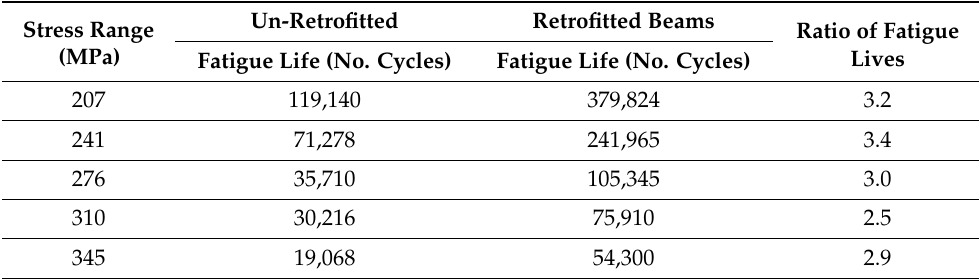
Table 2. Fatigue lives and of un-retrofitted and CFRP retrofitted steel beams with initial notches [144]. Stress